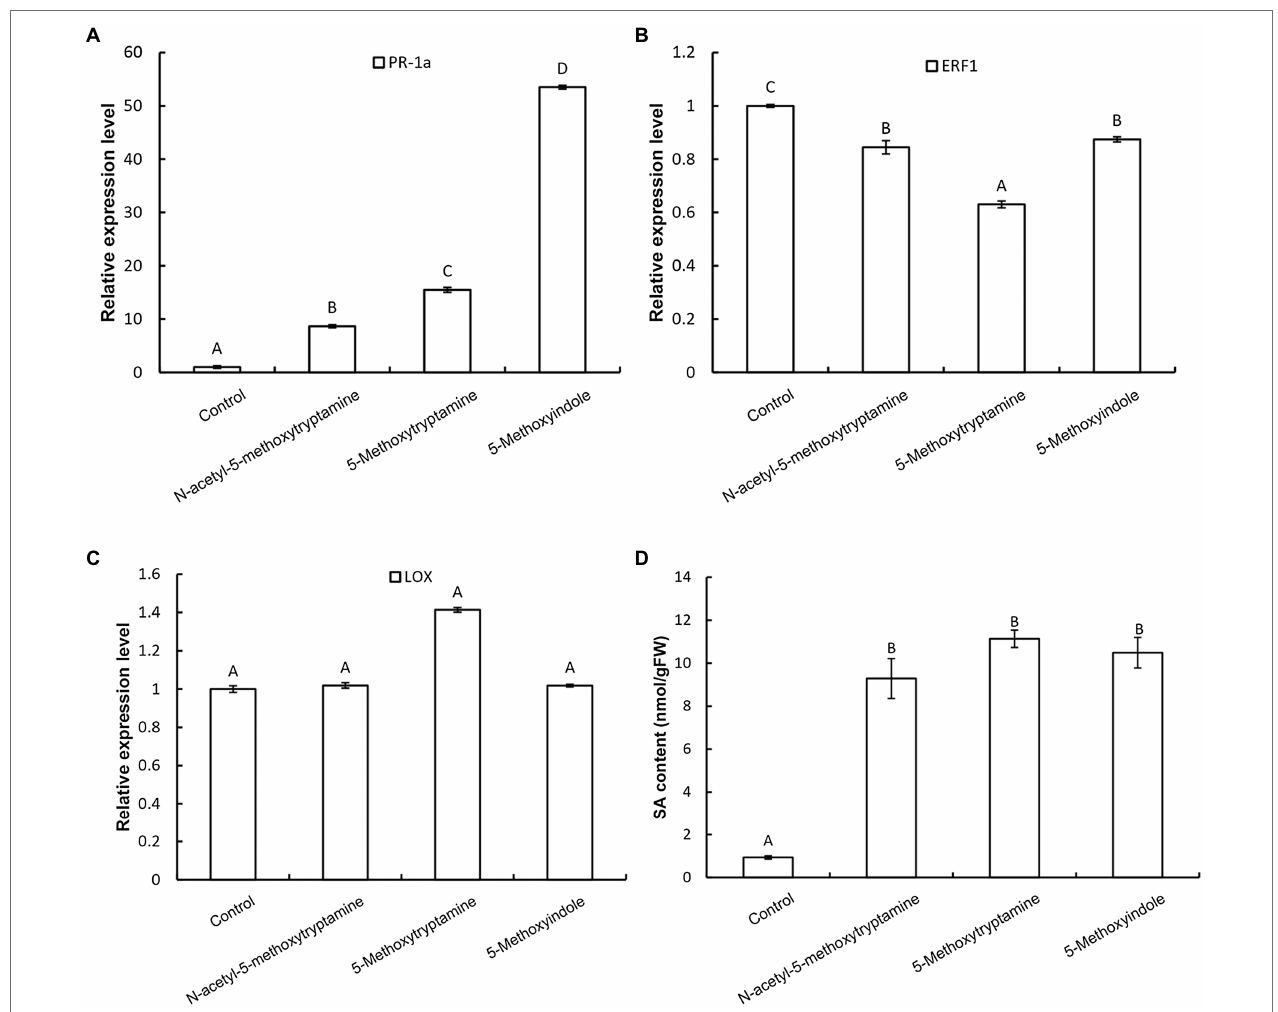
FIGURE 5 | Melatonin and MT-homologs activate an SA-mediated signaling pathway. The effect of MT, 5-methoxytryptamine, and 5-methoxyindole on the expression of SA-, ethylene-, and JA-dependent marker genes in N. benthamiana leaves. N. benthamiana leaves were treated with 0.005% (v/v) ethanol/water (control) or 50 μ M solutions of MT, 5-methoxytryptamine, or 5-methoxyindole. The relative expression of PR-1a (A) , ERF1 (B) , and LOX (C) by RT-qPCR. Expression values were normalized to the levels of EF-1a . Data are the mean ± standard deviation (SDs; n = 9). Columns with different letters indicate a significant difference ( p < 0.01) between the treatment groups as determined by a Duncan’s multiple range test. (D) Level of free SA in N. benthamiana leaves after treatment with MT, 5-methoxytryptamine, or 5-methoxyindole. Columns with different letters indicate a significant difference ( p < 0.01) between the treatment groups as determined by a Duncan’s multiple range test. FW, fresh